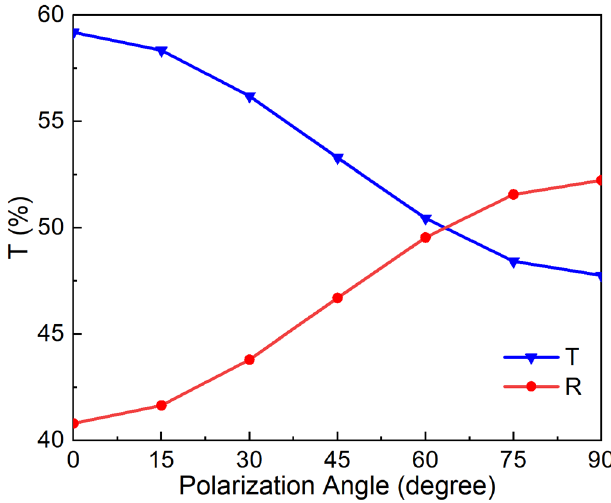
Figure 6. The variation of transmi tt ance and re fl ectance with the polarization angle.